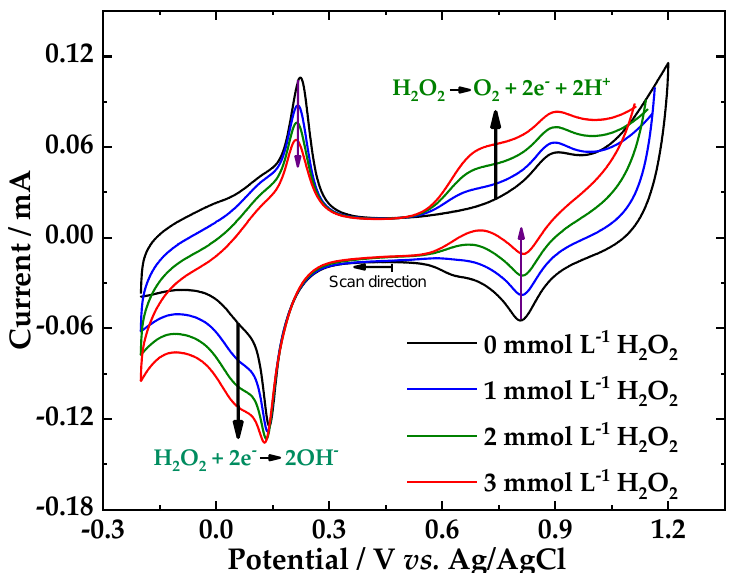
Figure10. Cyclic voltammograms of hydrogen peroxide at PB / ZrO 2 -fCNTs / GC electrode in a 0.1 mol · L − 1 Figure 10. Cyclic voltammograms of hydrogen peroxide at PB/ZrO 2 -fCNTs/GC electrode in a 0.1 PBS (pH 6.8) solution. Scan rate 40 mV · s − 1 mol·L −1 PBS (pH 6.8) solution. Scan rate 40 mV·s −1 .